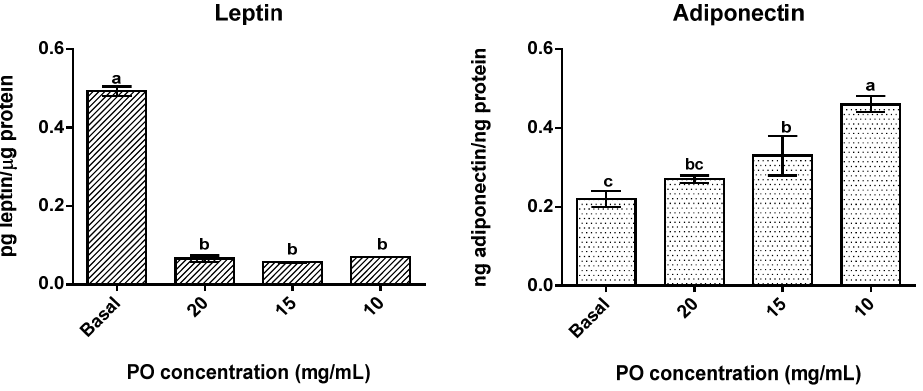
Figure 3. Effect of different concentrations of pomegranate oil on adipokines secretion in 3T3-L1 cells. Different letters represent significant differences as determined by the one-way ANOVA test ( p < 0.05).